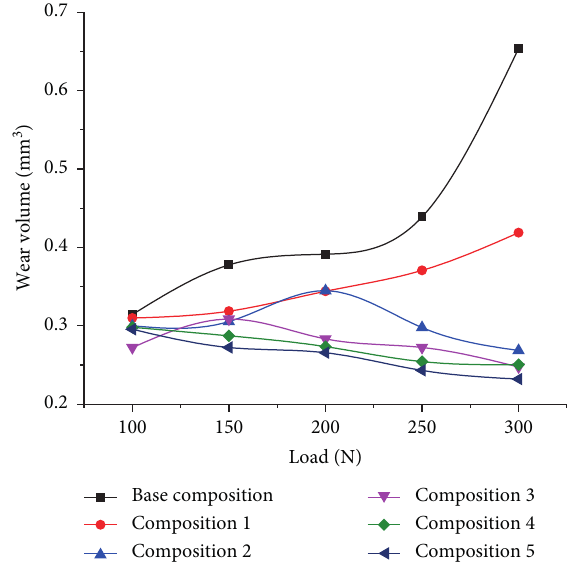
Figure 13: Wear volume v/s load at variable load.